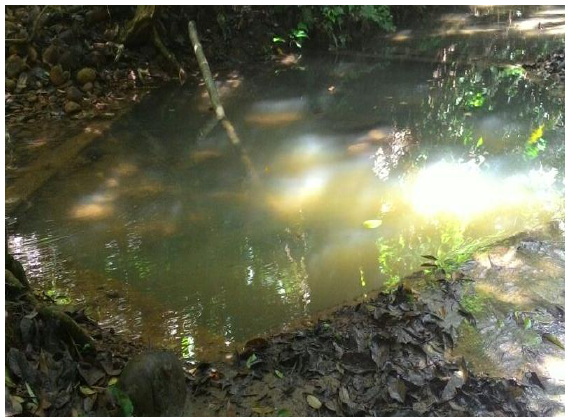
Figure 2: The spring-water catchment at the upper hill area, Bukit Bendera village and the plugged 5 inches PVC pipe.